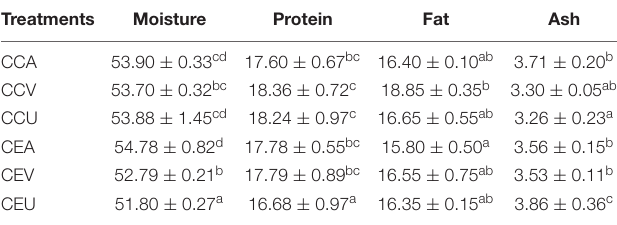
CCA = raw milk cheese without extract in aerobic packaging, CCV = raw milk cheese without extract in vacuum packaging, CCU = raw milk cheese without extract in vacuum packaging + UV-C, CEA = raw milk cheese with extract in aerobic packaging, CEV = raw milk cheese with extract in vacuum packaging; CEU = raw milk cheese with extract in vacuum packaging + UV-C. a − d Different lowercase superscripts indicate significant differences among treatments (P <